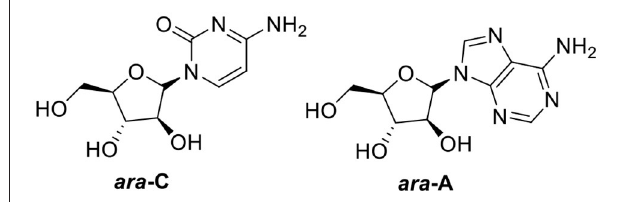
FIGURE 1 | Two FDA-approved